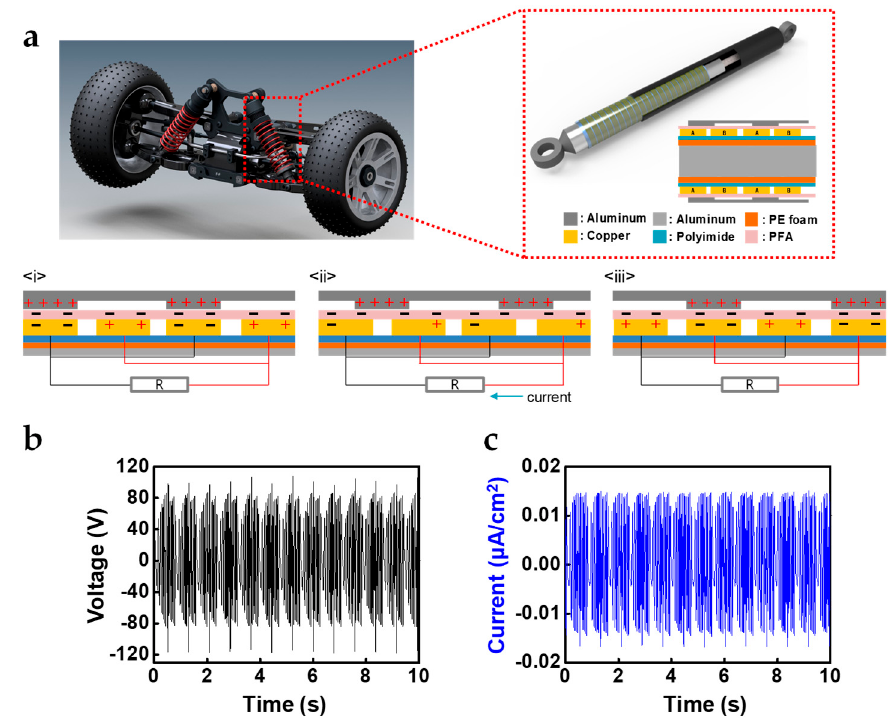
Figure 1. ( a ) Schematic structure and triboelectric regenerative suspension application and the working mechanism of a suspension-type free-standing mode triboelectric generator (STEG); ( b ) the output voltage and ( c ) short-circuit current according to the reciprocating movement of the outer cylinder with a displacement of 50 mm and speed of 100 mm/s.